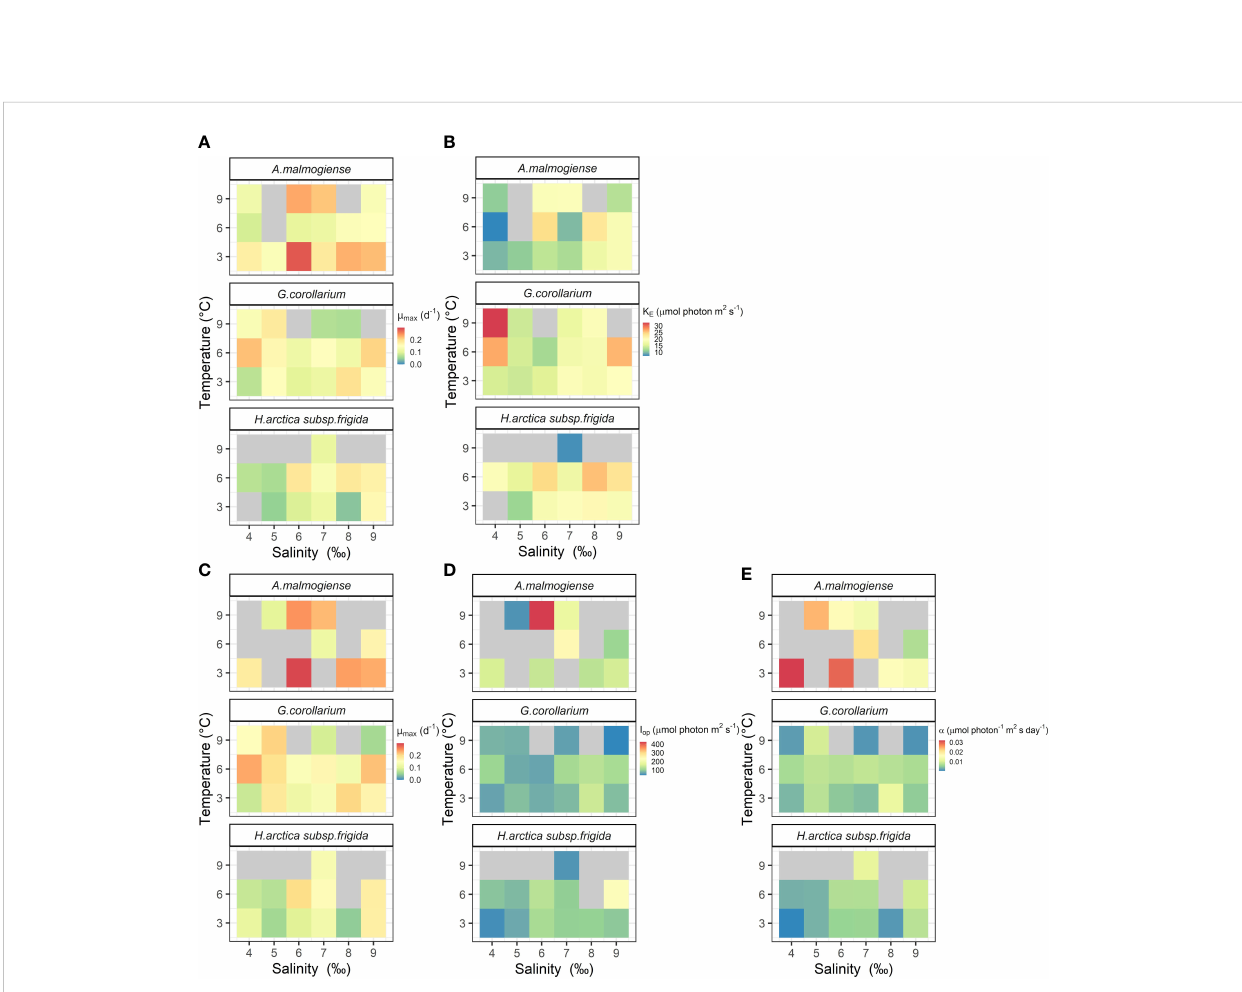
FIGURE 6 Observed growth rates for Apocalathium malmogiense , Gymnodinium corollarium , and Heterocapsa arctica subsp. frigida . The curves represent the fi tted growth-intensity models (MacIntyre et al., 2002 and Eilers & Peeters, 1988) in different temperatures and salinities.